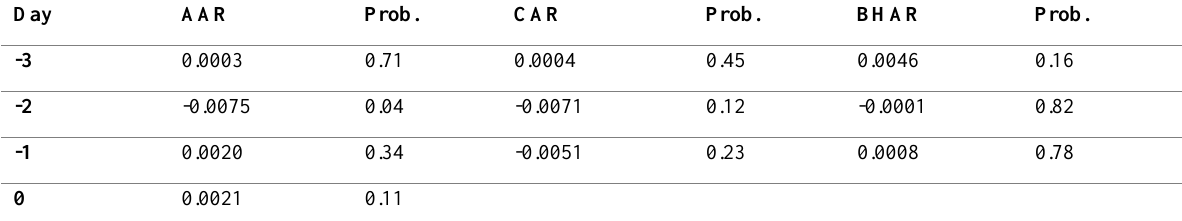
Table 3: The Effect of Negative Earnings Announcement on Stocks (on and before the